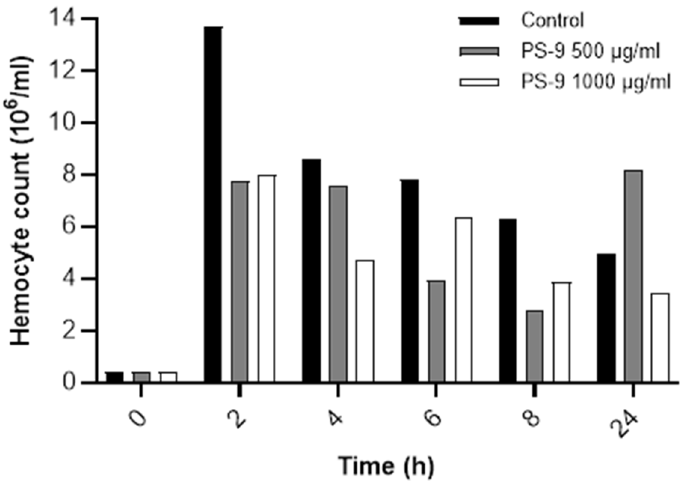
Figure 6. Hemocyte density (10 6 / mL ) of G. mellonella larvae treated with PS9 . Hemocytes densities were evaluated from 0–24 h following PS9 inoculation.